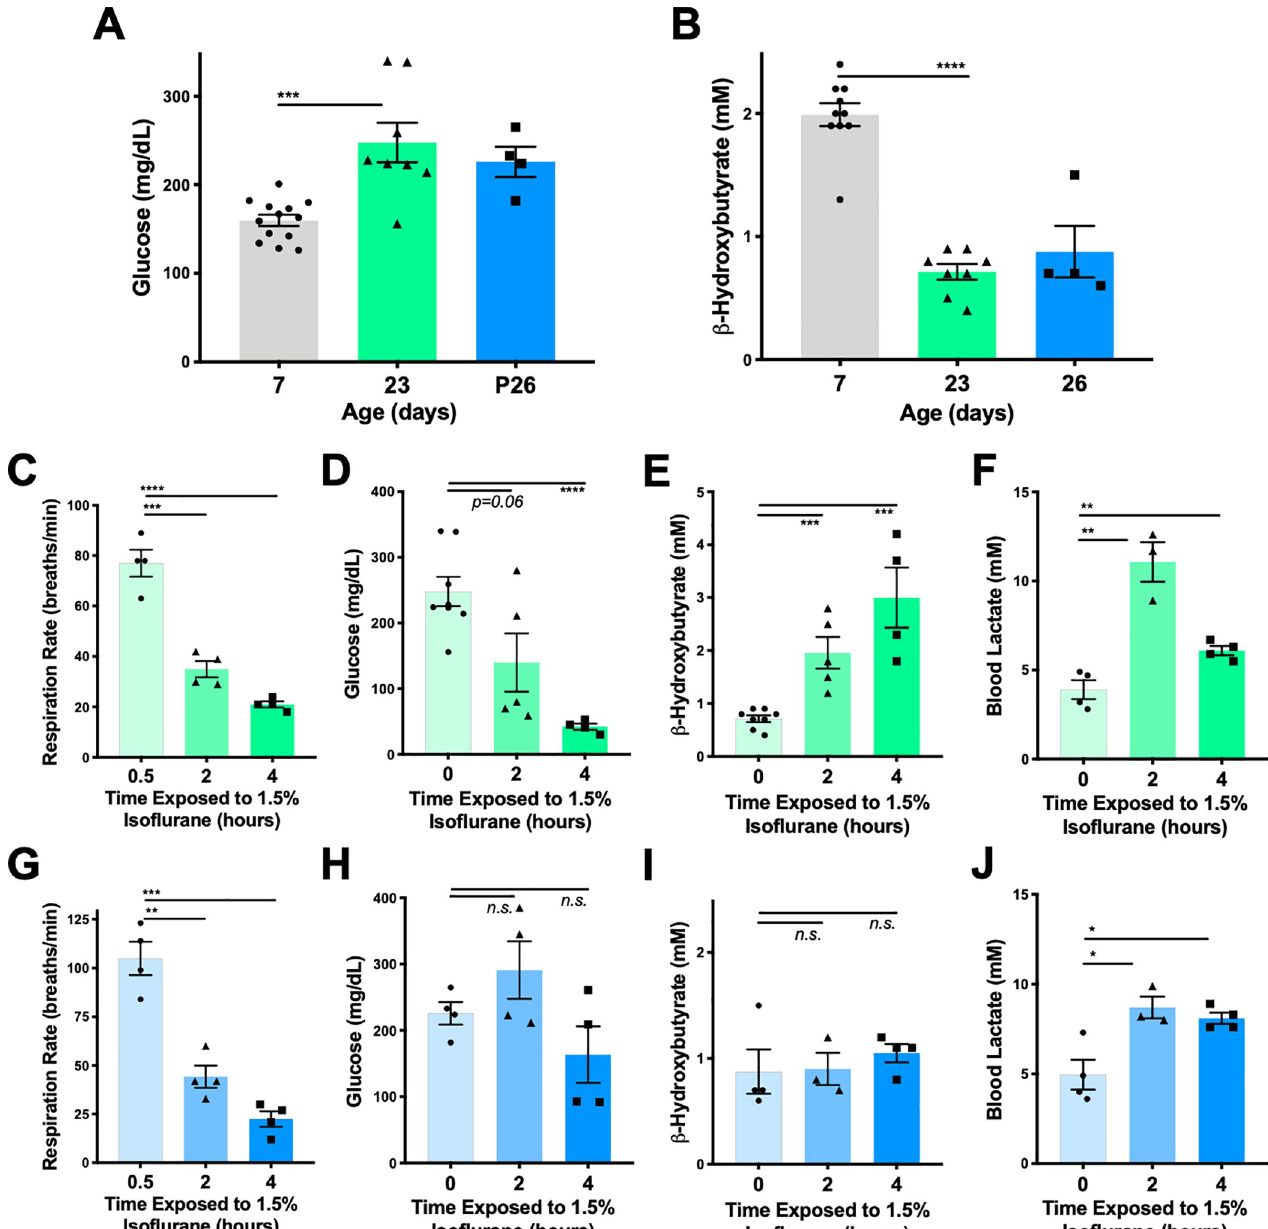
Fig 6. Physiological impact of anesthesia as a function of age. ( A ) Baseline blood glucose in mice at 7 (neonatal), 23 (2 days post-weaning), and 26 days of age. ( B ) Baseline blood ß-hydroxybutyrate in mice at 7 (neonatal), 23 (2 days post-weaning), and 26 days of age. ( C ) Respiratory rate of P23 mice as a function of time exposed to 1.5% isoflurane. ANOVA p-value < 0.0001; ���� p < 0.0001, ��� p < 0.005 post-hoc pairwise t-test. n = 4, 4, and 4 for 0.5, 2, and 4 hours, respectively. ( D ) P23 mouse blood glucose concentration at baseline and at 2 or 4 hours of anesthesia with 1.5% isoflurane. ANOVA p-value = 0.0009; ���� p < 0.0001 post-hoc pairwise t-test. n = 8, 4, and 5 for 0, 2, and 4 hours, respectively. ( E ) P23 mouse blood ß-hydroxybutyrate concentration at baseline and at 2 or 4 hours of anesthesia with 1.5% isoflurane. ANOVA p-value < 0.0001; ��� p � 0.0004 post-hoc pairwise t-test. n = 8, 4, and 5 for 0, 2, and 4 hours of exposure, respectively. ( F ) P23 mouse blood lactate concentration at baseline and at 2 or 4 hours of anesthesia with 1.5% isoflurane. ANOVA p-value = 0.0002; �� p < 0.001, post-hoc pairwise t-test. n = 8, 4, and 5 for 0, 2, and 4 hours of exposure, respectively. ( G ) Respiratory rate of P26 mice as a function of time exposed to 1.5% isoflurane. ANOVA p-value < 0.0001; �� p = 0.001, ��� p = 0.0001 post-hoc pairwise t-test. n = 4, 4, and 4 for 0.5, 2, and 4 hours, respectively. ( H ) P26 mouse blood glucose concentration at baseline and at 2 or 4 hours of anesthesia with 1.5% isoflurane. ANOVA and post-hoc t-tests non-significant (n.s.). n = 4, 4, and 4 for 0, 2, and 4 hours, respectively. ( I ) P26 mouse blood ß-hydroxybutyrate concentration at baseline and at 2 or 4 hours of anesthesia with 1.5% isoflurane. ANOVA and post-hoc t-tests non-significant (n.s.). n = 4, 4, and 4 for 0, 2, and 4 hours, respectively. ( J ) P26 mouse blood ß-hydroxybutyrate concentration at baseline and at 2 or 4 hours of anesthesia with 1.5% isoflurane. ANOVA �� p = 0.006. � p < 0.02 by post-hoc t-tests non-significant. n = 4, 4, and 4 for 0, 2, and 4 hours, respectively.